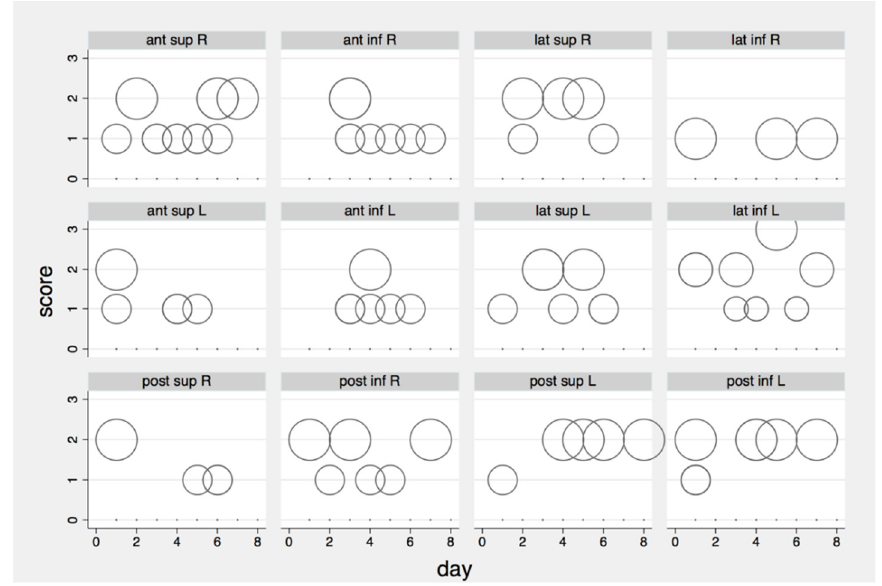
Figure 4. Abnormal LUS score per area and follow up day (ant, anterior; lat, lateral; post, posterior; sup, superior; inf, inferior; L, left; R, right; a larger dot symbolizes more patients).